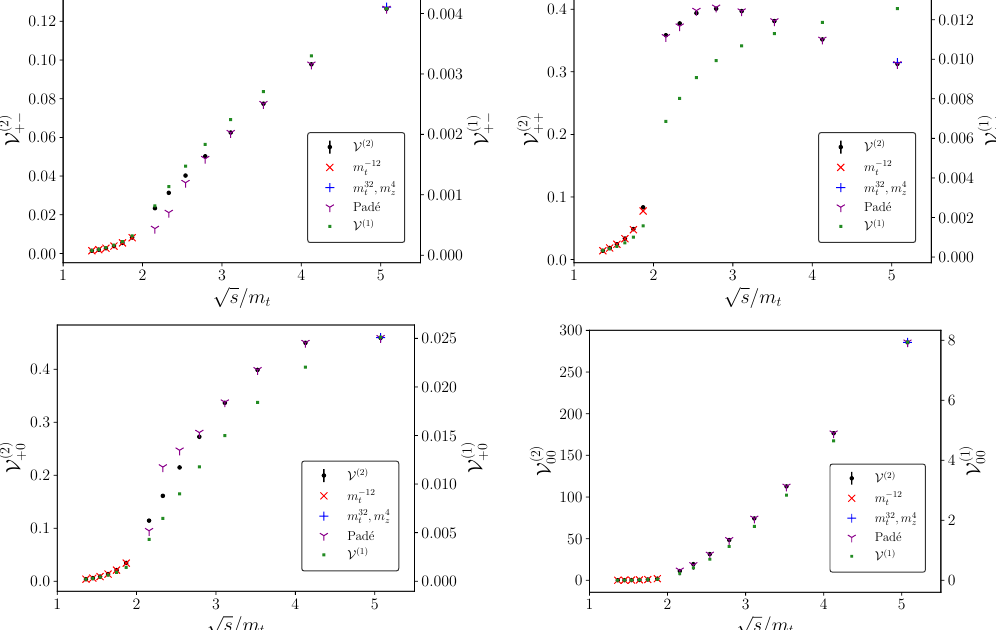
√ Figure 9. The s dependence of 1-loop and 2-loop interferences for polarised ZZ production in gluon fusion at cos( θ ) = − 0 . 1286